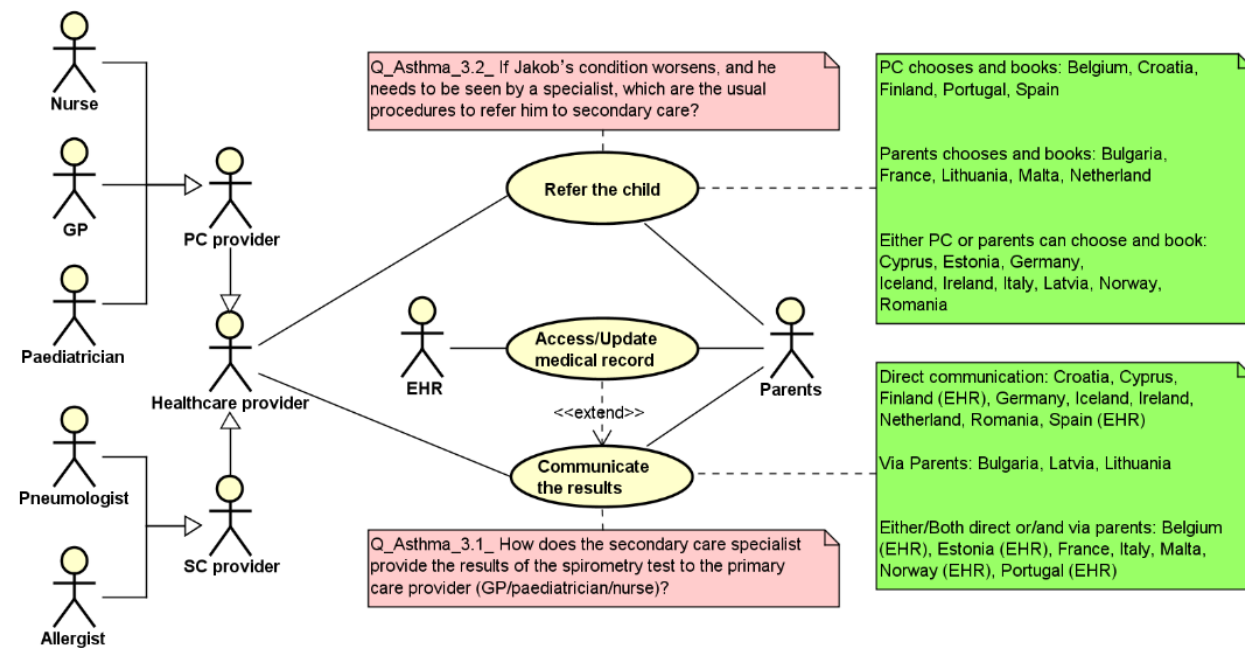
Figure 4. Use case diagram highlighting the responses reported by the CAs (green notes) for the specified processes (red notes).